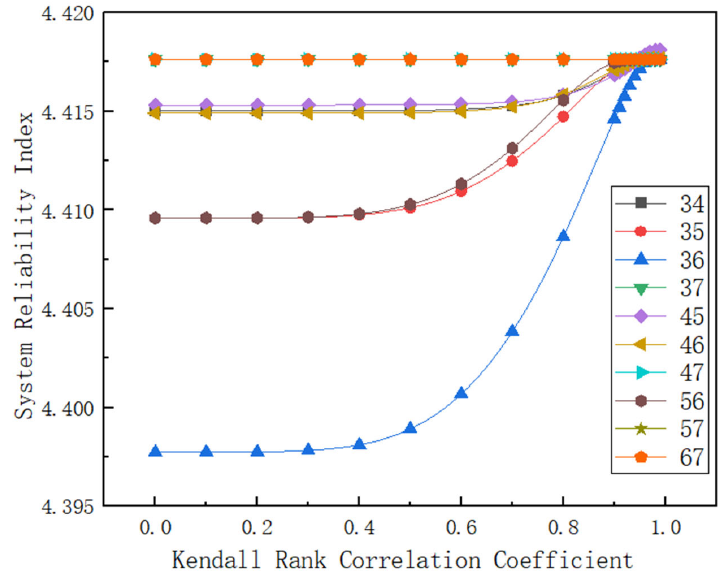
Figure 3. Effect of the change of the failure modes combination correlation coefficient on the reliability index of the system.